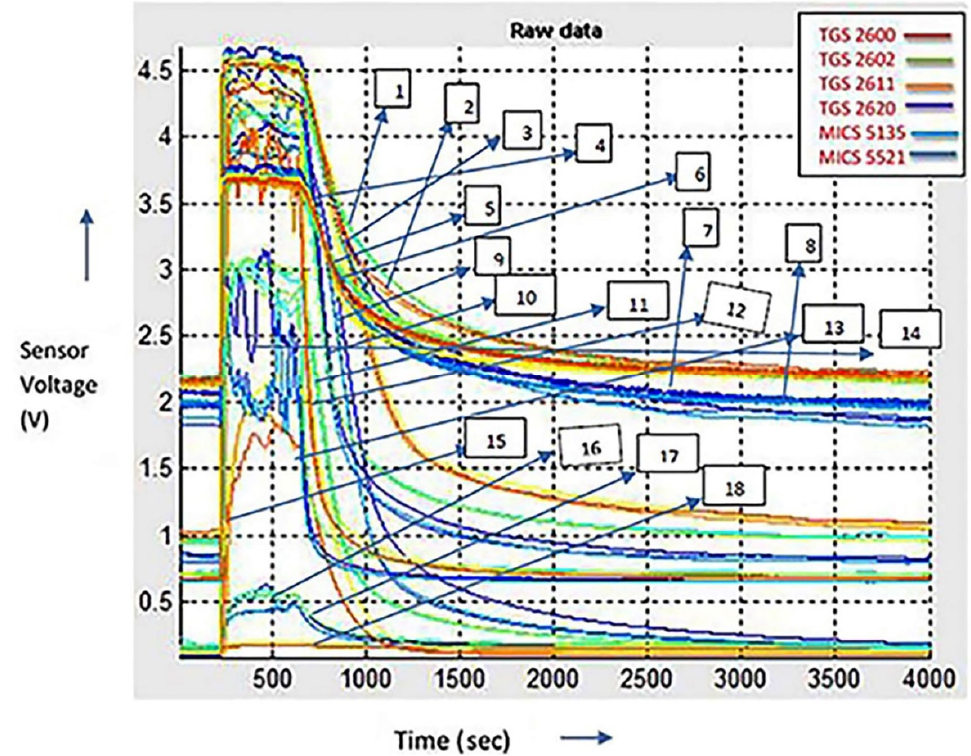
Figure 3. Time response of sensors based on metal oxide semiconductor (MOS) techniques for three various samples of volatile organic compounds (VOCs), each having three statistical records for the database (D).